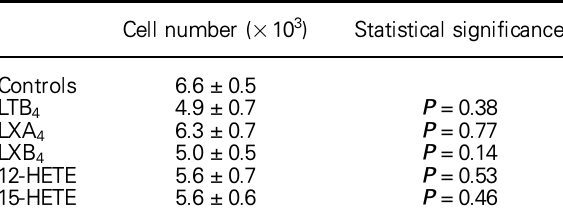
Table 2. Effects of lipoxygenase metabolites of AA on human marrow stromal cell number. Cell number was determined after 3 days of growth with AA metabolites (1 m M). Results (in 1 3 10 3 cells) are reported as mean ± SEM of four independent experiments in